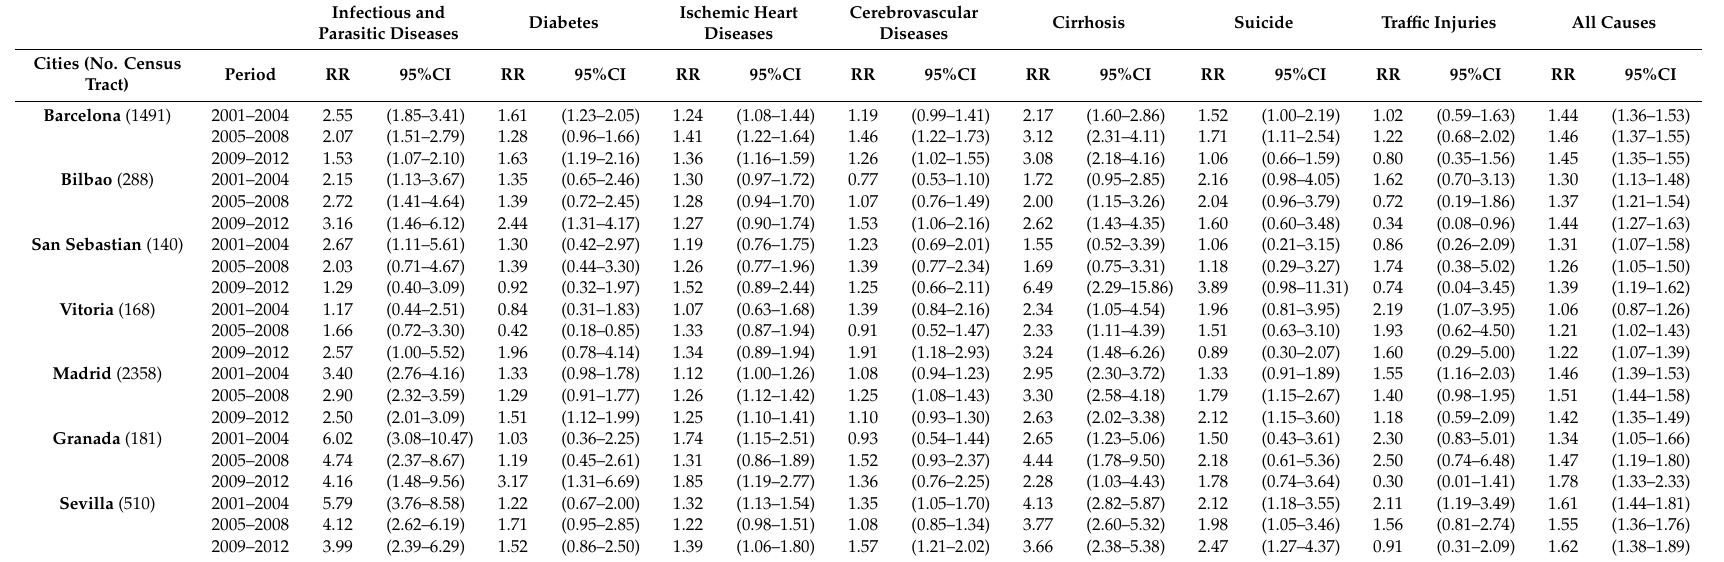
Table 3. Association between mortality and the deprivation index. Relative risk comparing the 95th to 5th percentiles of the deprivation index by period and cause of death in 7 Spanish cities for men,